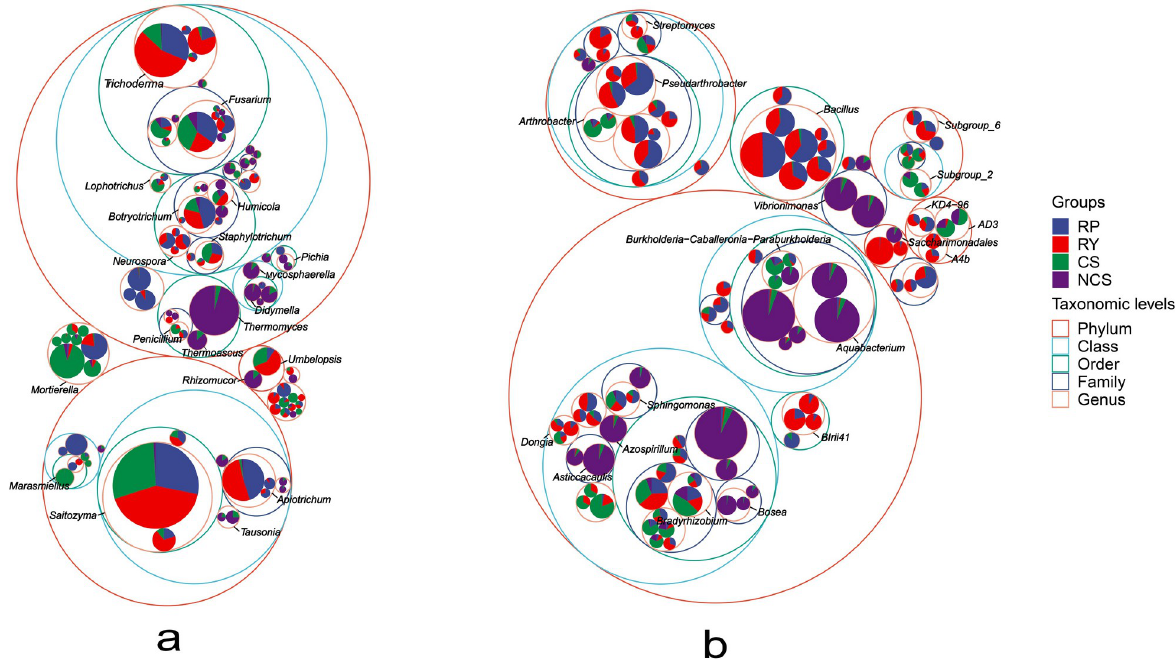
Fig 2. Circle packing of different soil and rhizosphere samples for fungi (a) and bacteria (b). The largest circle represents the phylum level, and the gradually shrinking circle represents class, order, family, and genus according to the gradient. The area of the fan in the circle represents the corresponding abundance and the top 20 genera have been identified with short